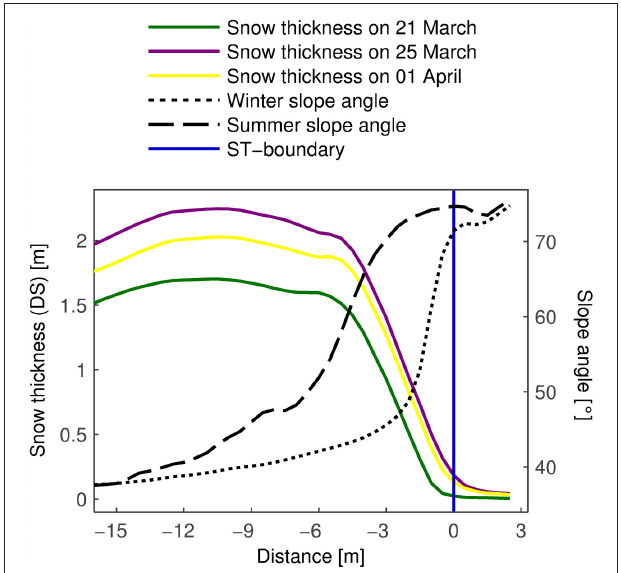
FIGURE 11 | Averaged transects of snow thickness on different days and of winter and summer slope angle. DS did not decrease much in the extremely steep terrain. The curves are similar to the 1 DS transect ( Figure 9 ) but with a horizontal shift of about − 3m.